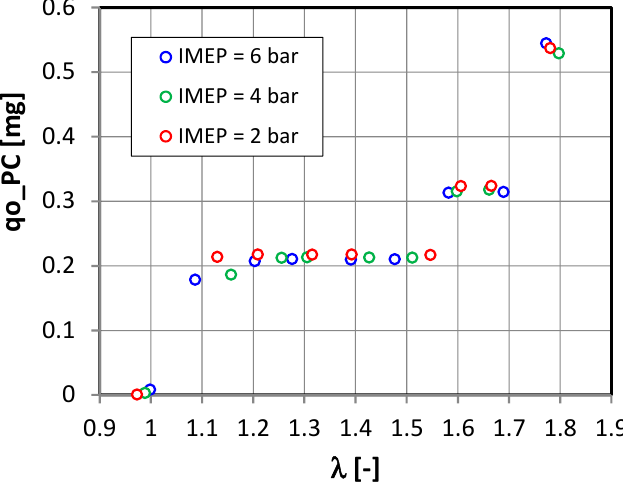
Figure 6. Test conditions: prechamber fuel dose values as a function of the engine load.